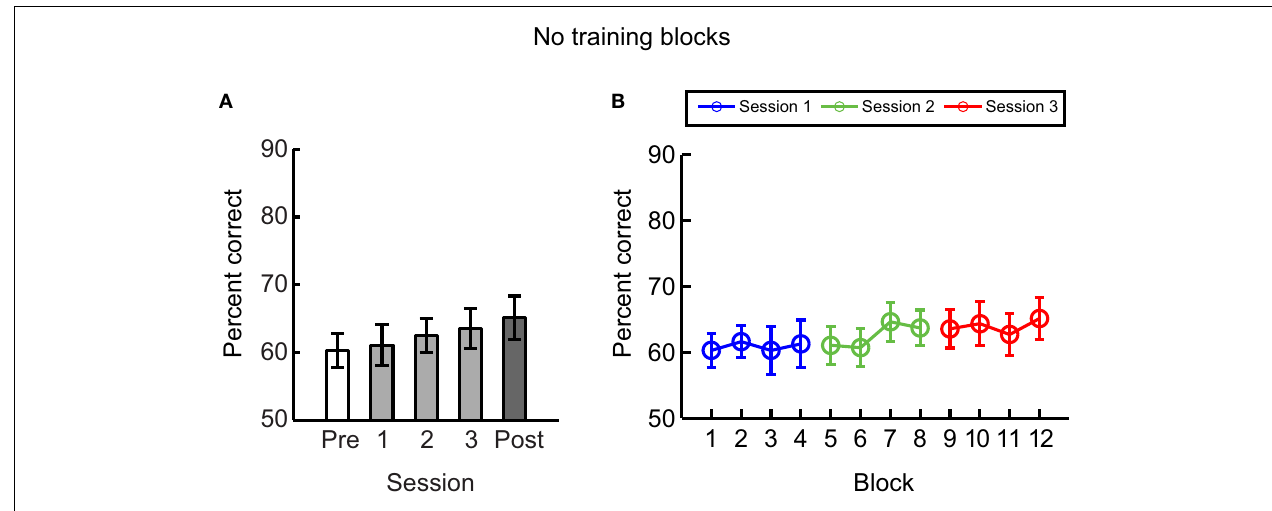
FIGURE 5 | Experiment 4. Mean performance across participants per (A) session and per (B) block when only test but no training blocks were included in each session. Error bars indicate the standard error of the mean across participants.